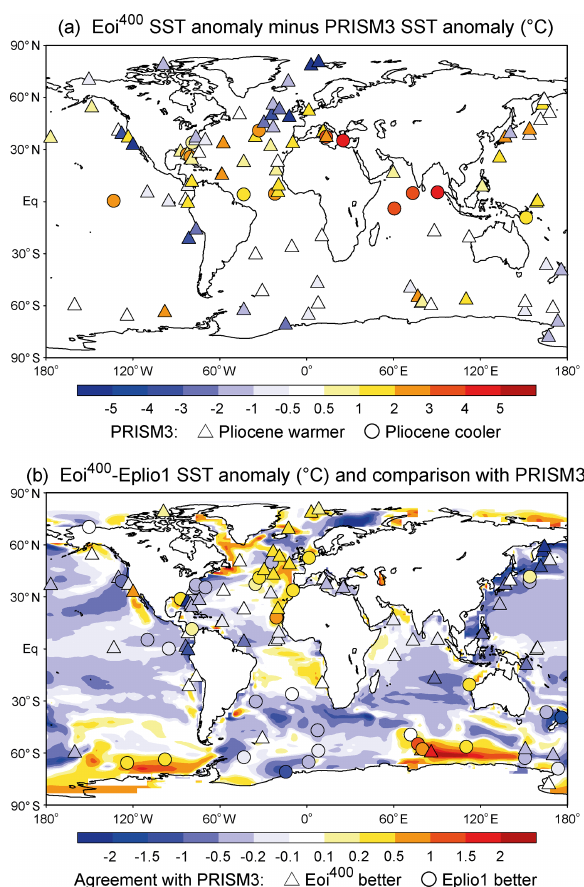
Figure 16. (a) Comparison of annual mean model SST anoma- lies and PRISM3 proxy data SST anomalies. Blue (red) indicates that model SST anomalies are smaller (greater) than those of proxy data. The shape of the symbols indicates whether proxy data sug- gest higher (triangle) SST in the Pliocene or lower (circle). (b) The difference between PlioMIP1 and PlioMIP2 SST. The shape of the symbols at PRISM3 locations indicates whether PlioMIP2 agrees better with proxy data (triangle) or whether PlioMIP1 agrees better (circle).